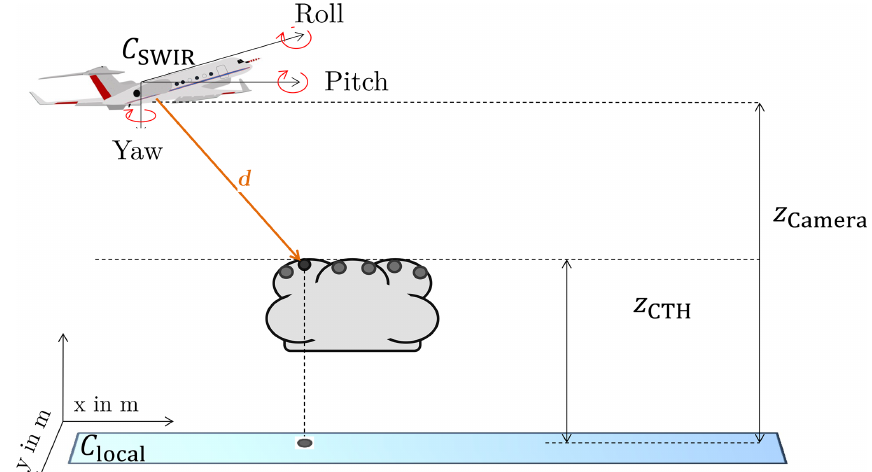
Figure 3. Illustration of the transformation from cloud pixels in the camera coordinate system C SWIR into the local distance-based reference system. Aircraft yaw, pitch, and roll axes are defined in the top left-hand